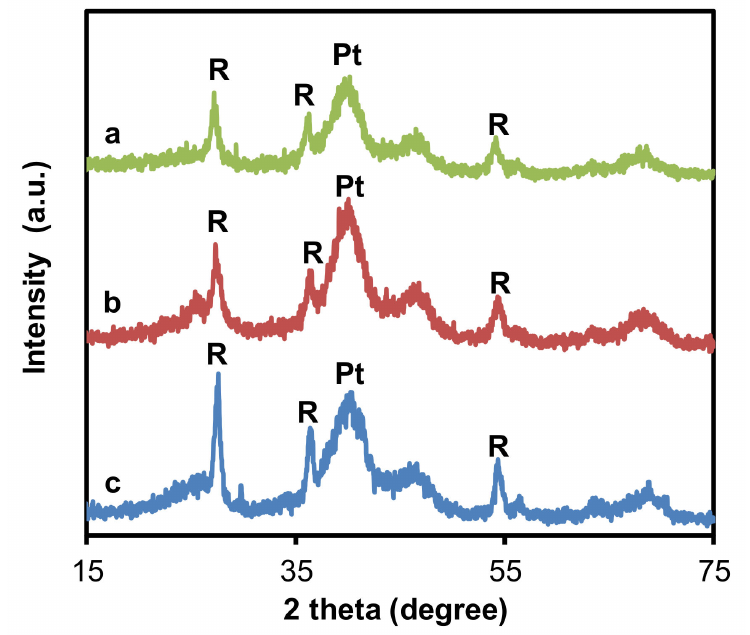
Figure 1. XRD patterns of the Pt/Ti 0.8 Mo 0.2 O 2 -C electrocatalysts with Ti 0.8 Mo 0.2 O 2 /C = 25/75 ratio: (a) Pt/75BP; (b) Pt/75F-BP; (c) Pt/75V; R: rutile, Pt: